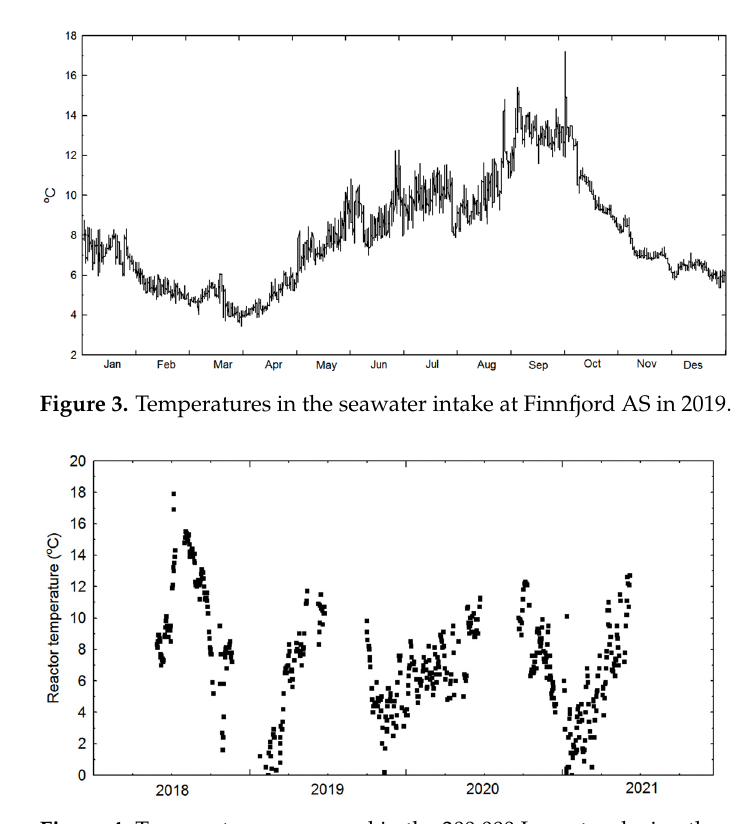
Figure 4. Temperatures measured in the 300,000 L reactor during the cultivation sessions.